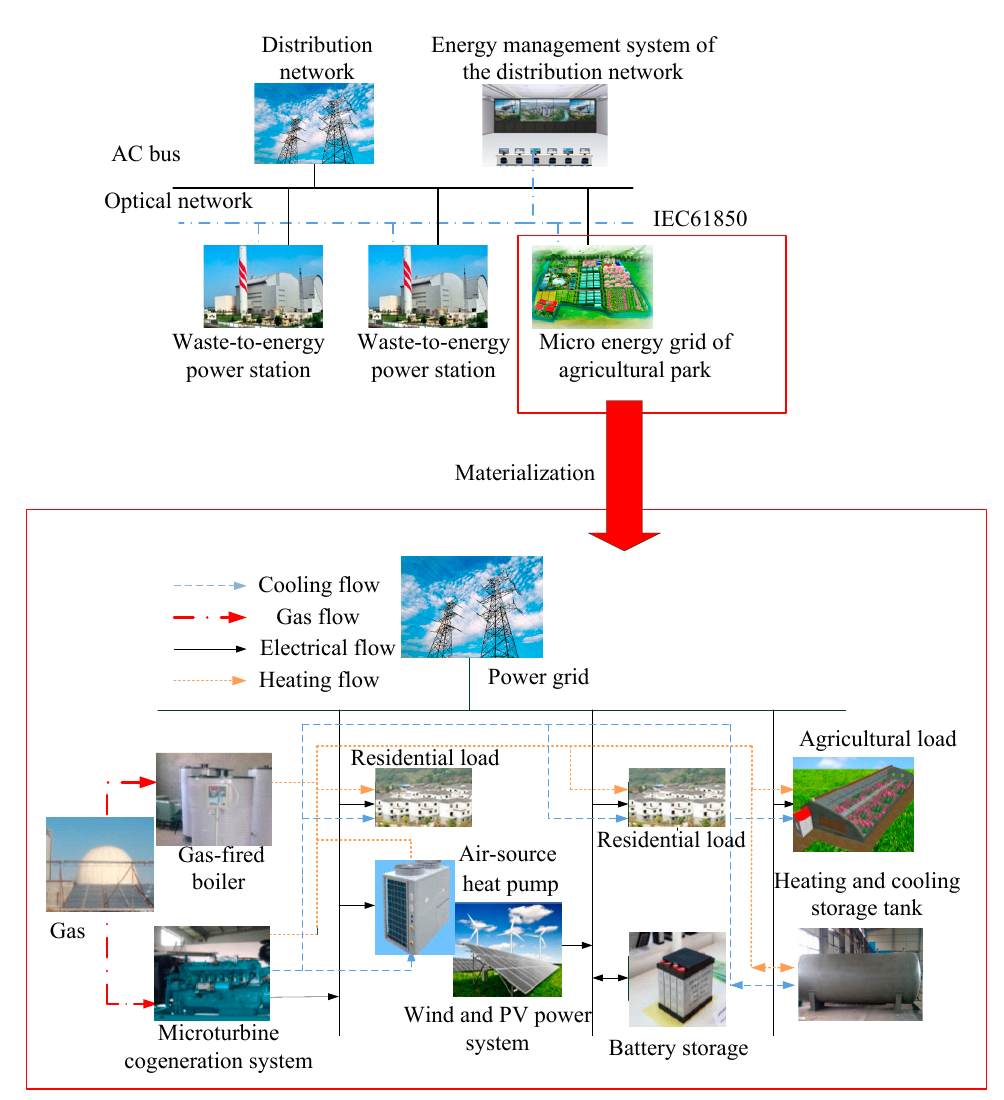
Figure 2. Operating structure of a distribution network comprising a micro energy grid.